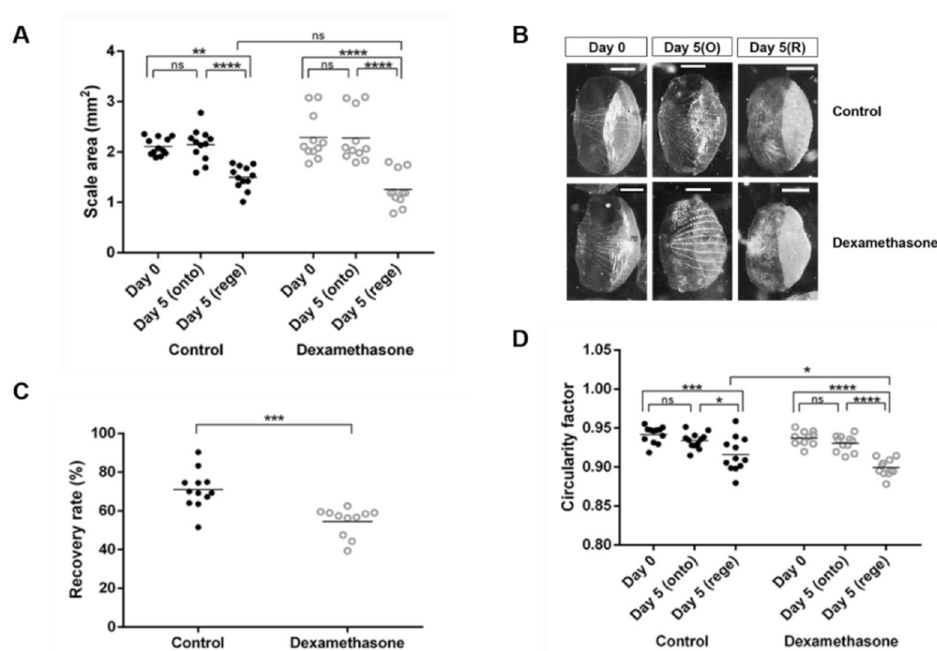
Figure 1. Morphometric analyses of zebrafish scales on day 0, ontogenetic scales on day 5, and regenerated scales on day 5 from the control (black dots) and dexamethasone-treated groups (open dots). Each dot represents an average value of each fish: ( A ) Scale area (mm 2 ), ( B ) Representative scales from control and dexamethasone group on day 0 and day 5 (scale bars = 0.5 mm), ( C ) Percentage of the recovery rate of scale regeneration, ( D ) Circularity factor (4 π A/P 2 ; where A is the surface area and P is the perimeter). Interactions between groups were assessed with two-way ANOVA with Tukey’s multiple comparisons test. Data are shown as the mean ± SEM (**** p ≤ 0.0001; *** p ≤ 0.001; ** p ≤ 0.01; * p ≤ 0.05; ns: not significant). Error bars indicate the standard error of the